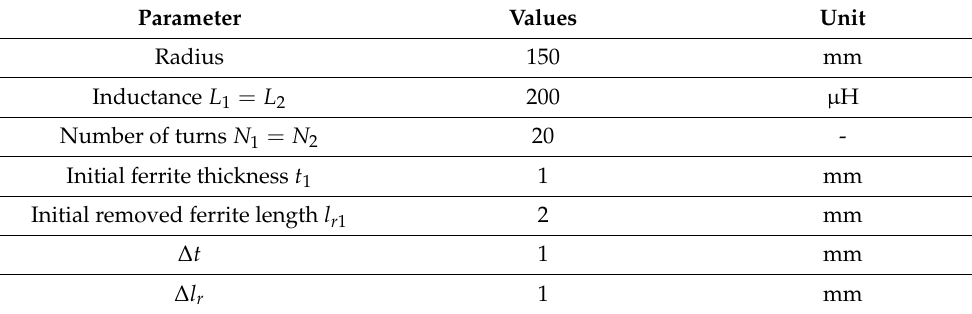
Figure 18. Optimization method on the ferrites applied in circular coupler: ( a ) Primary core; ( b ) Secondary core. Table 5. Parameters for the ferrite of circular coupler in a 3D simulation.